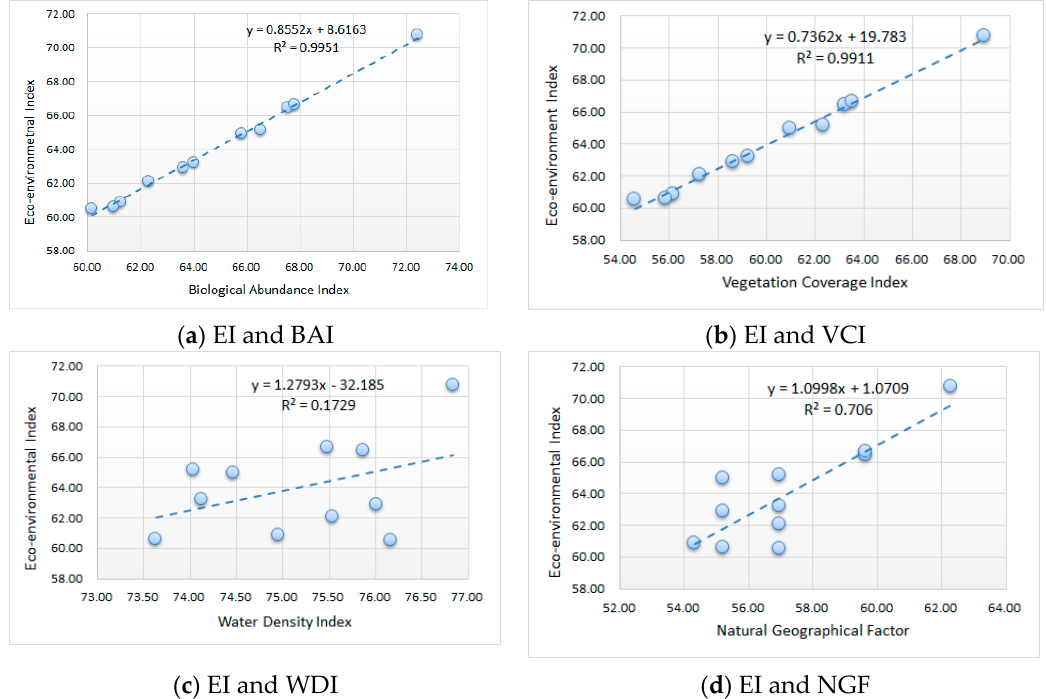
Figure 7. Correlation coefficients between the EI and the sub-indices. ( a ) the correlation coefficients between the EI and BAI; ( b ) the correlation coefficients between the EI and VCI; ( c ) the correlation coefficients between the EI and WDI; ( d ) the correlation coefficients between the EI and NGF.